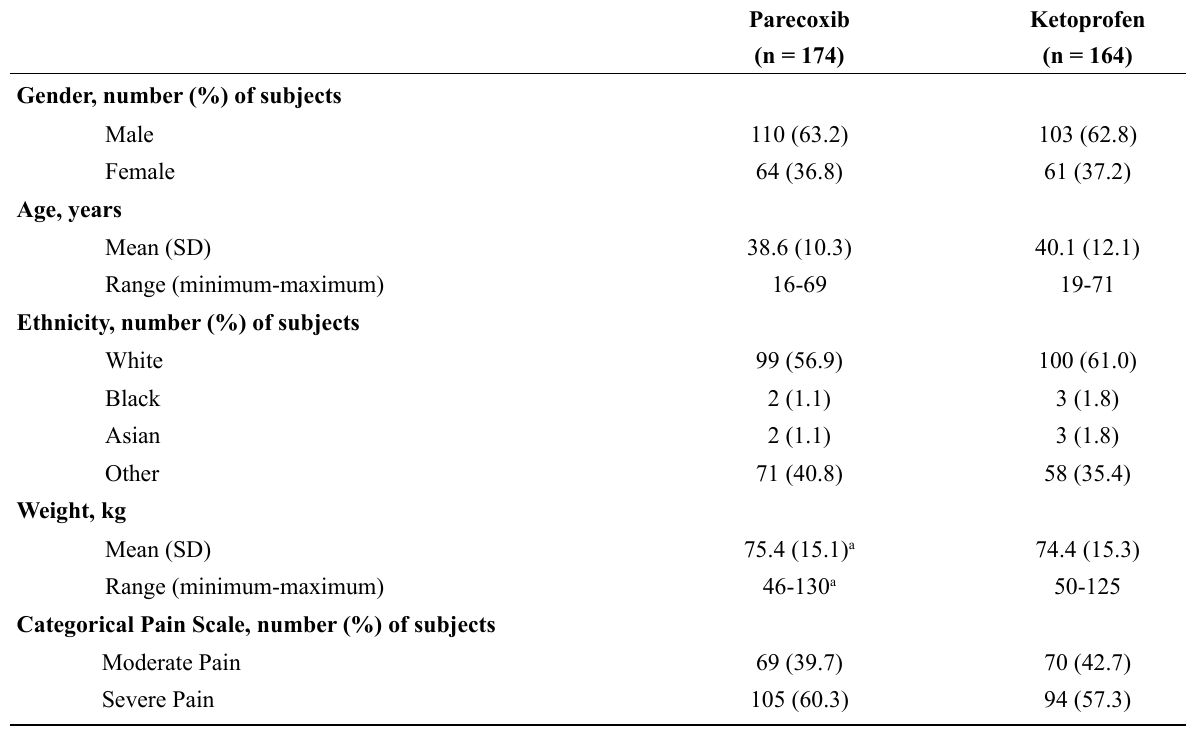
Table 1 – Summary of baseline demographic characteristics.